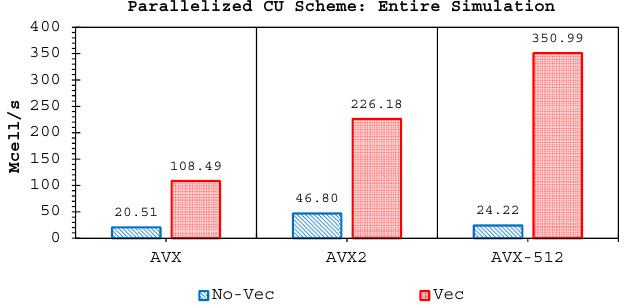
Figure 22. Single-node performance of the non-vectorized and vectorized CU scheme with parallelization (entire